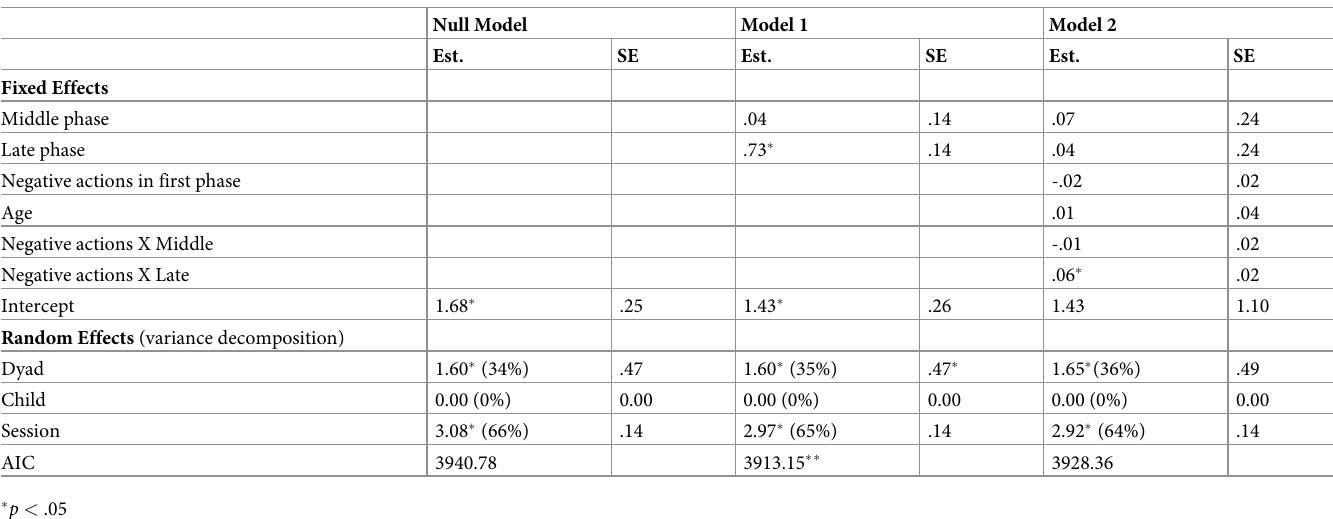
Table 3. Cross-classified multilevel model examining frequency of game sequences with phase, negative actions in the first phase, and age as